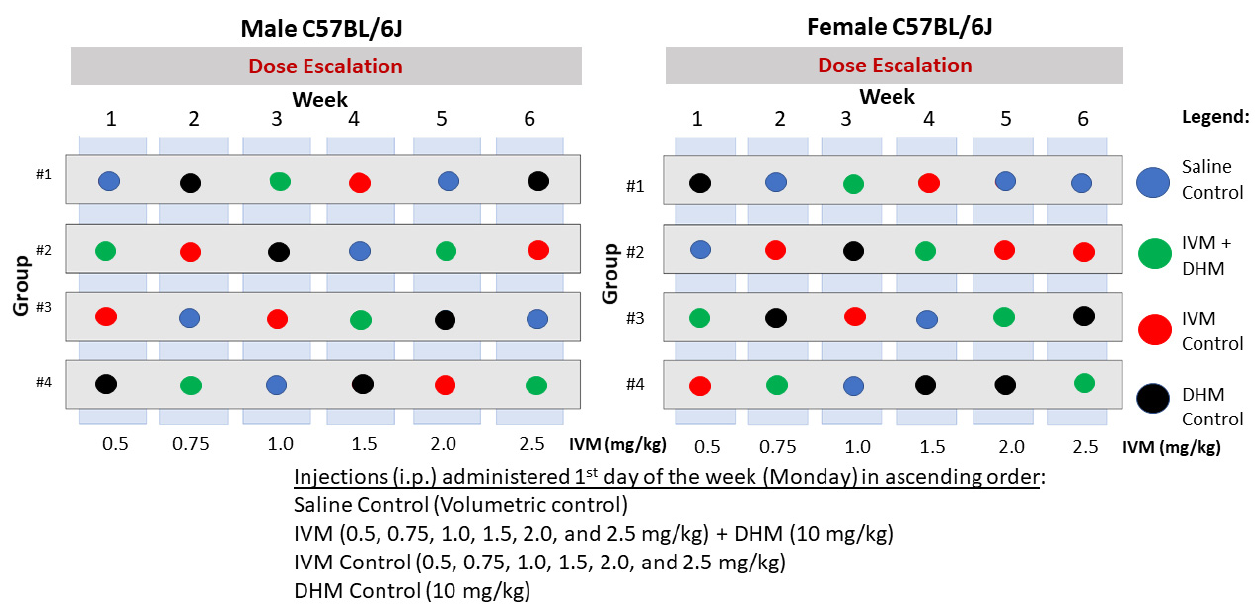
Figure 1. Randomized within-subjects drug treatment layout for behavioral analysis. Male and female C57BL/6J mice were separated into four cohorts and treated randomly each week with incremental doses of IVM as either (1) IVM dose control (red), (2) IVM + DHM (green), (3) Saline control (blue), and (4) DHM control (black).